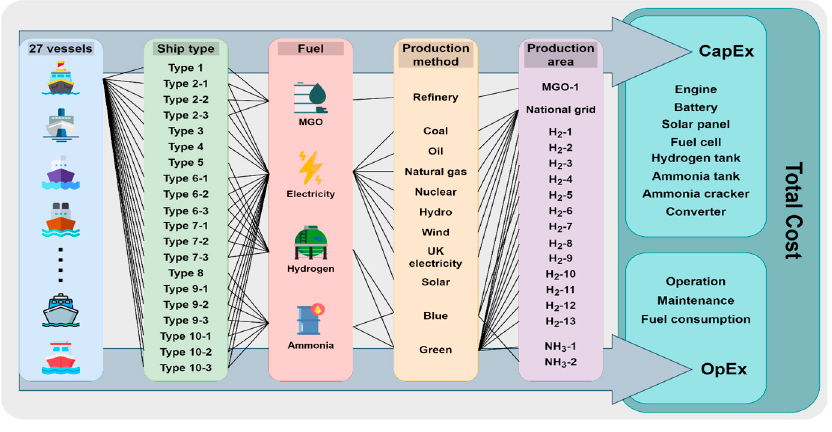
Figure 3. Outline of the proposed LCCA.